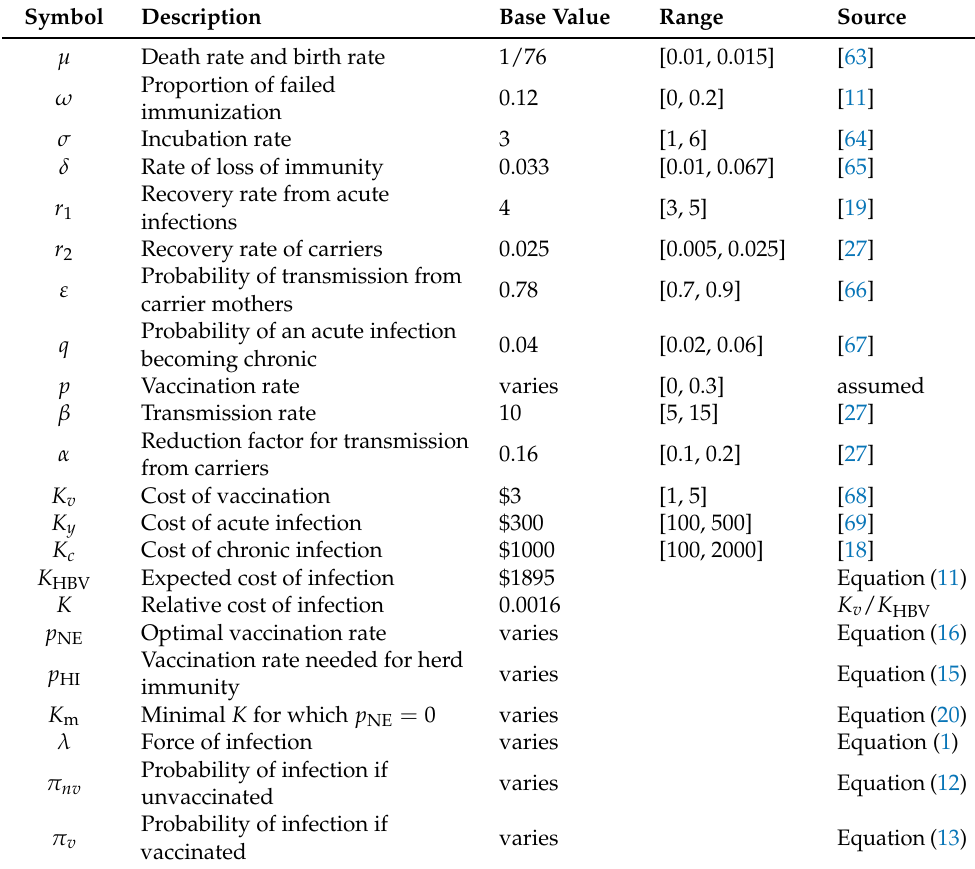
Table 1. Description of the symbols and parameters used in the model. The rates are per capita per year. The costs are in US